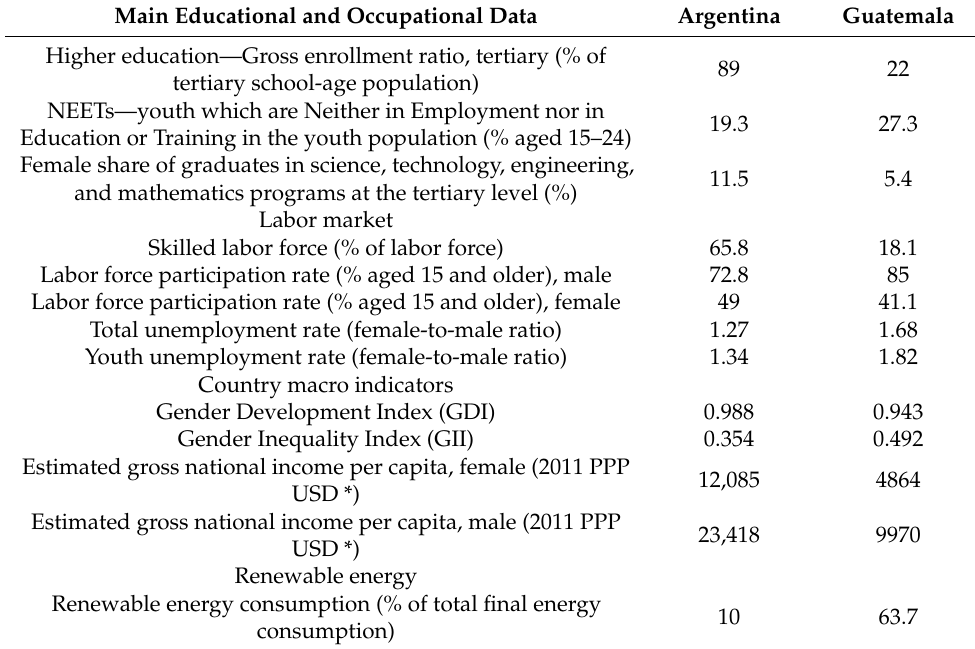
Table 1. Argentina and Guatemala: a